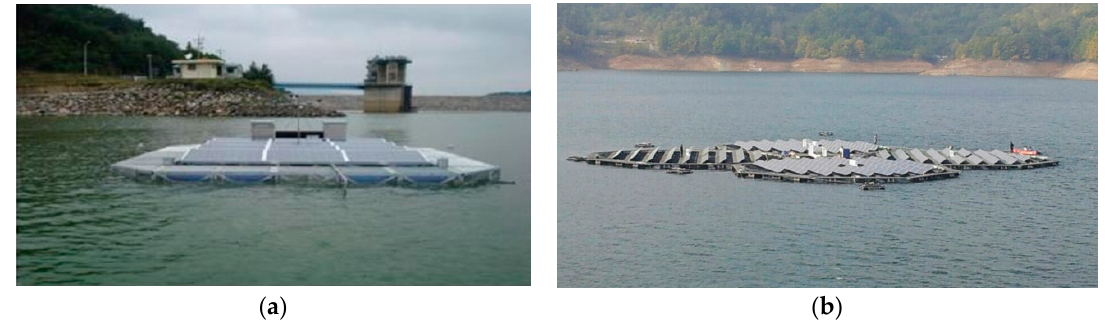
Figure 3. Floating photovoltaic power generation structure. ( a ) Structure in Juam Dam; ( b ) structure in Hapcheon Dam.